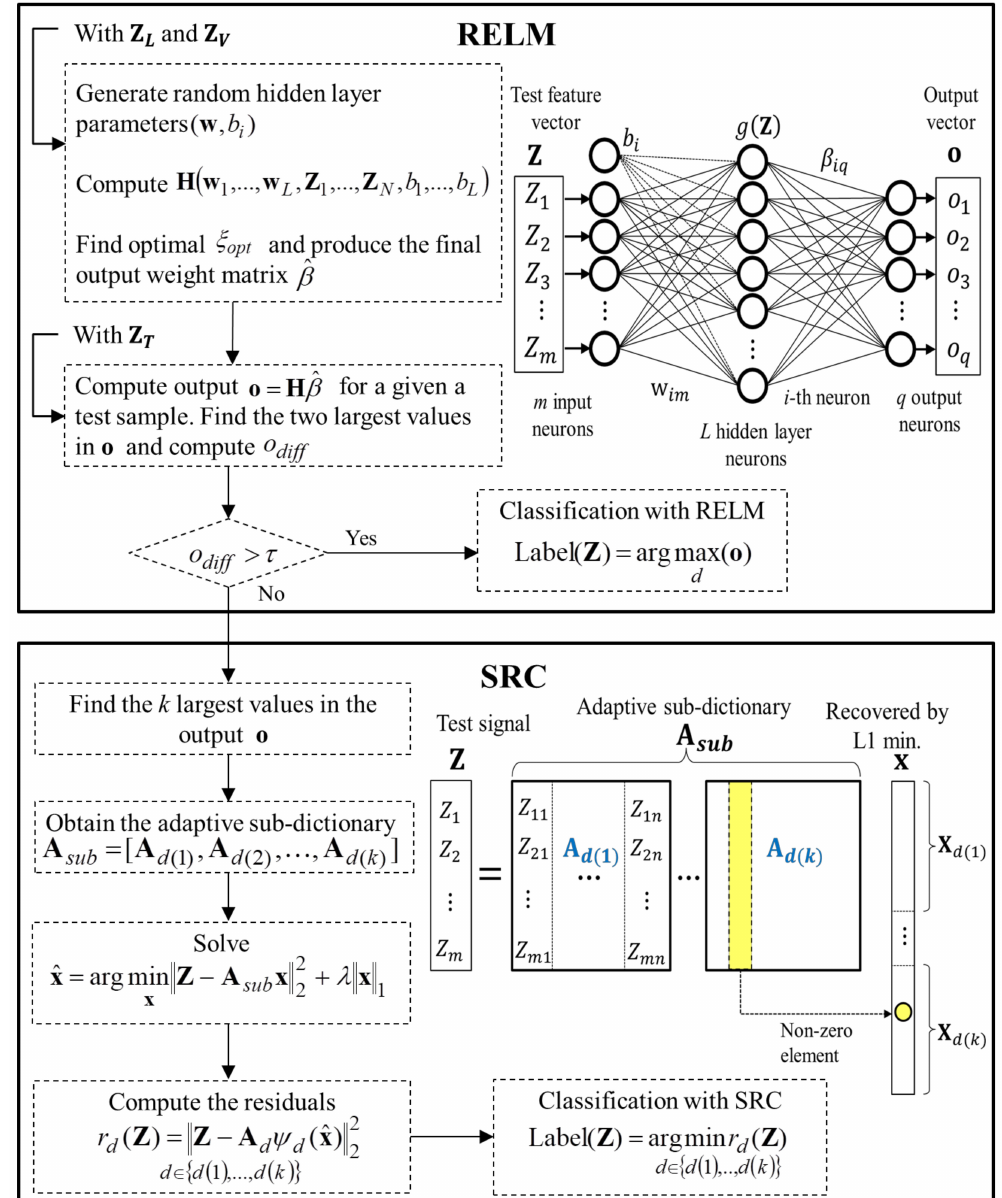
Figure 4. The proposed hybrid fault classification